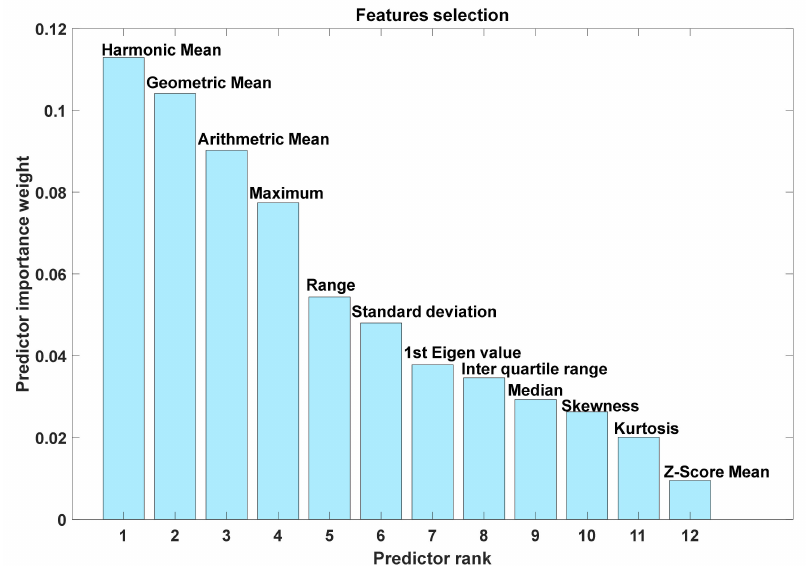
Figure 7. Important features in descending